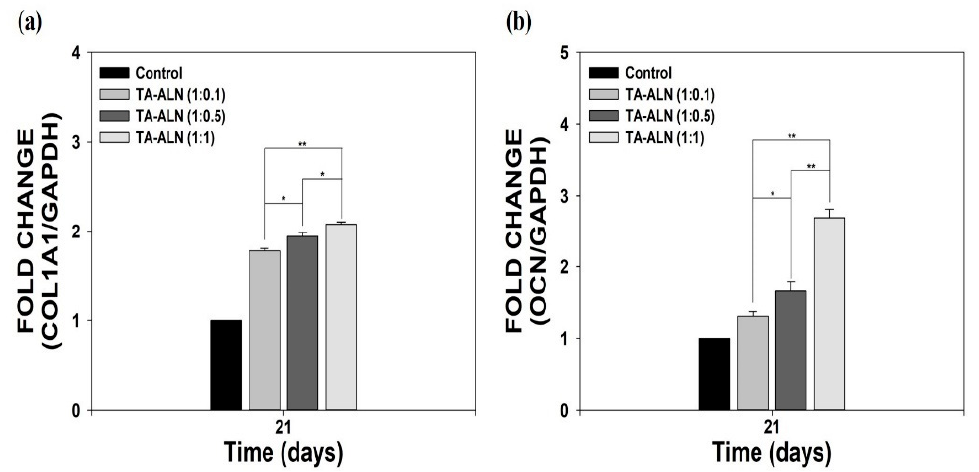
Figure 6. The mRNA levels of osteogenesis-related genes, including ( a ) COL1A1 and ( b ) OCN in MC3T3-E1 cells treated with TA-ALN (1:0.1), TA-ALN (1:0.5), and TA-ALN (1:1) after 21 days of incubation. The p -value is a comparison between all TA-ALN types. * p < 0.05; ** p < 0.01; n = 4 per group.